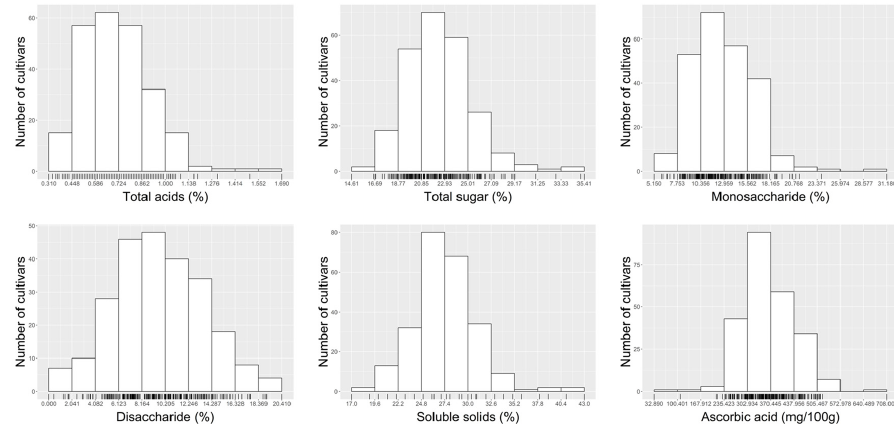
Figure 7. Histogram distribution of fruit chemical traits of 243 Chinese jujube cultivars.